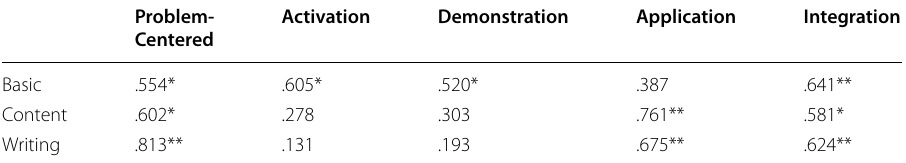
Table 9 Spearman’s rank correlation coefficient between FPI, Writing Test, and Basic Japanese Proficiency Test